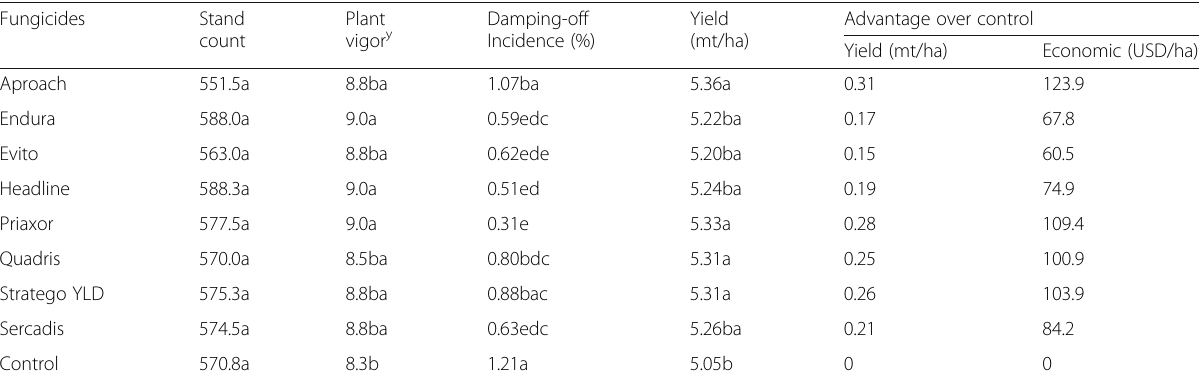
Table 3 Effects of using commercial foliar fungicides as seed treatments on stand count, vigor, damping-off incidence (%), and yields in a soybean field inoculated with Pythium ultimum var. ultimum at West Curtiss Research Farm, Iowa State University, Ames, Iowa x Fungicides Stand Plant count vigor